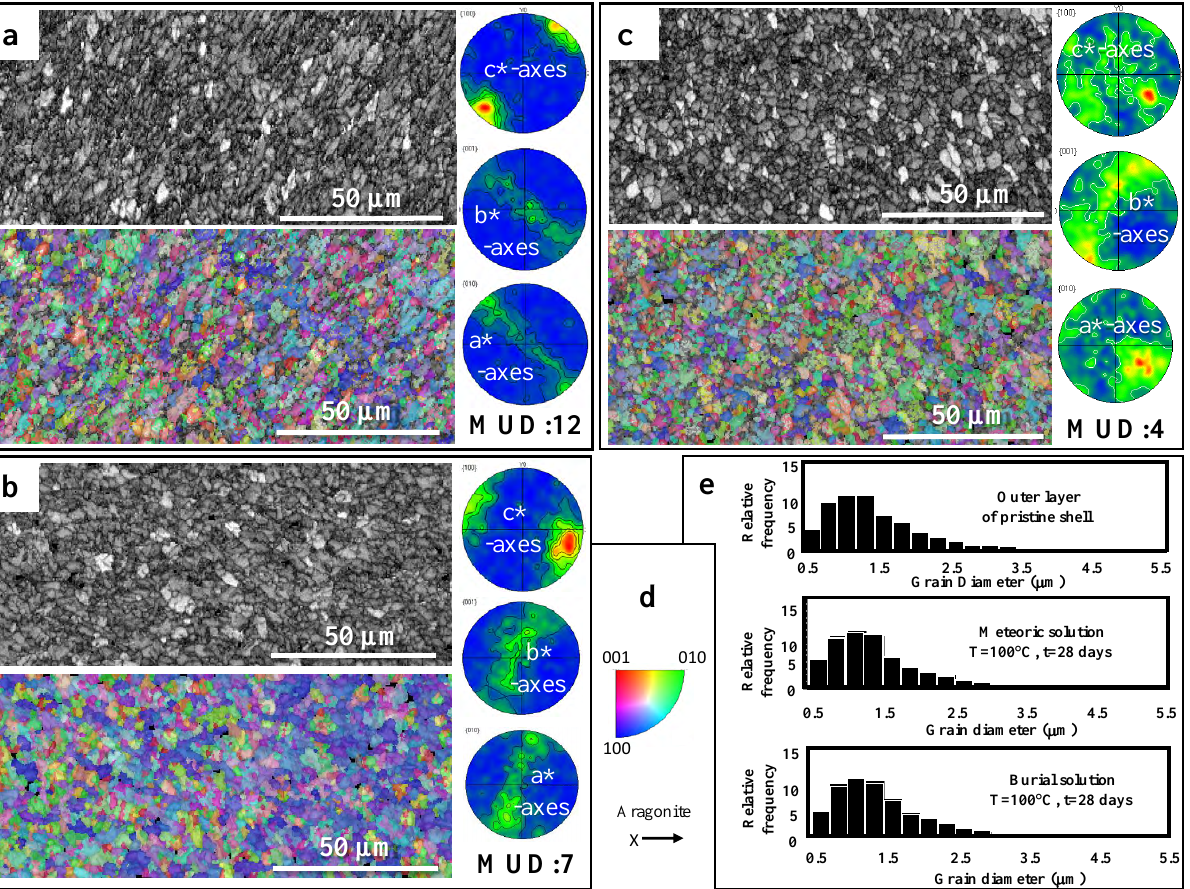
Figure 6. EBSD band contrast images (greyscale) and orientation maps (coloured; colour code given in d ) with corresponding pole figures of pristine (a) and experimentally altered (b, c) Arctica islandica shell material. In the pole figures, colour is coded for pole density, with the maximum in red corresponding to the given MUD value for each set of pole figures, respectively. All EBSD measurements were taken at the outer shell layer. Hydrothermal alteration was applied for 28 days at 100 ◦ C. The solutions used were artificial meteoric fluid in (b) and artificial burial fluid in (c) . As the pole figures show, in comparison to the microstructure of pristine Arctica islandica (a) , the crystal orientation pattern in the skeleton is not affected by treatment with the solutions. (e) Grain diameter statistics for pristine and experimentally altered Arctica islandica shell material obtained from the EBSD measurements are shown in (a) – (c) . There is no significant difference in grain size between pristine and hydrothermally altered Arctica islandica